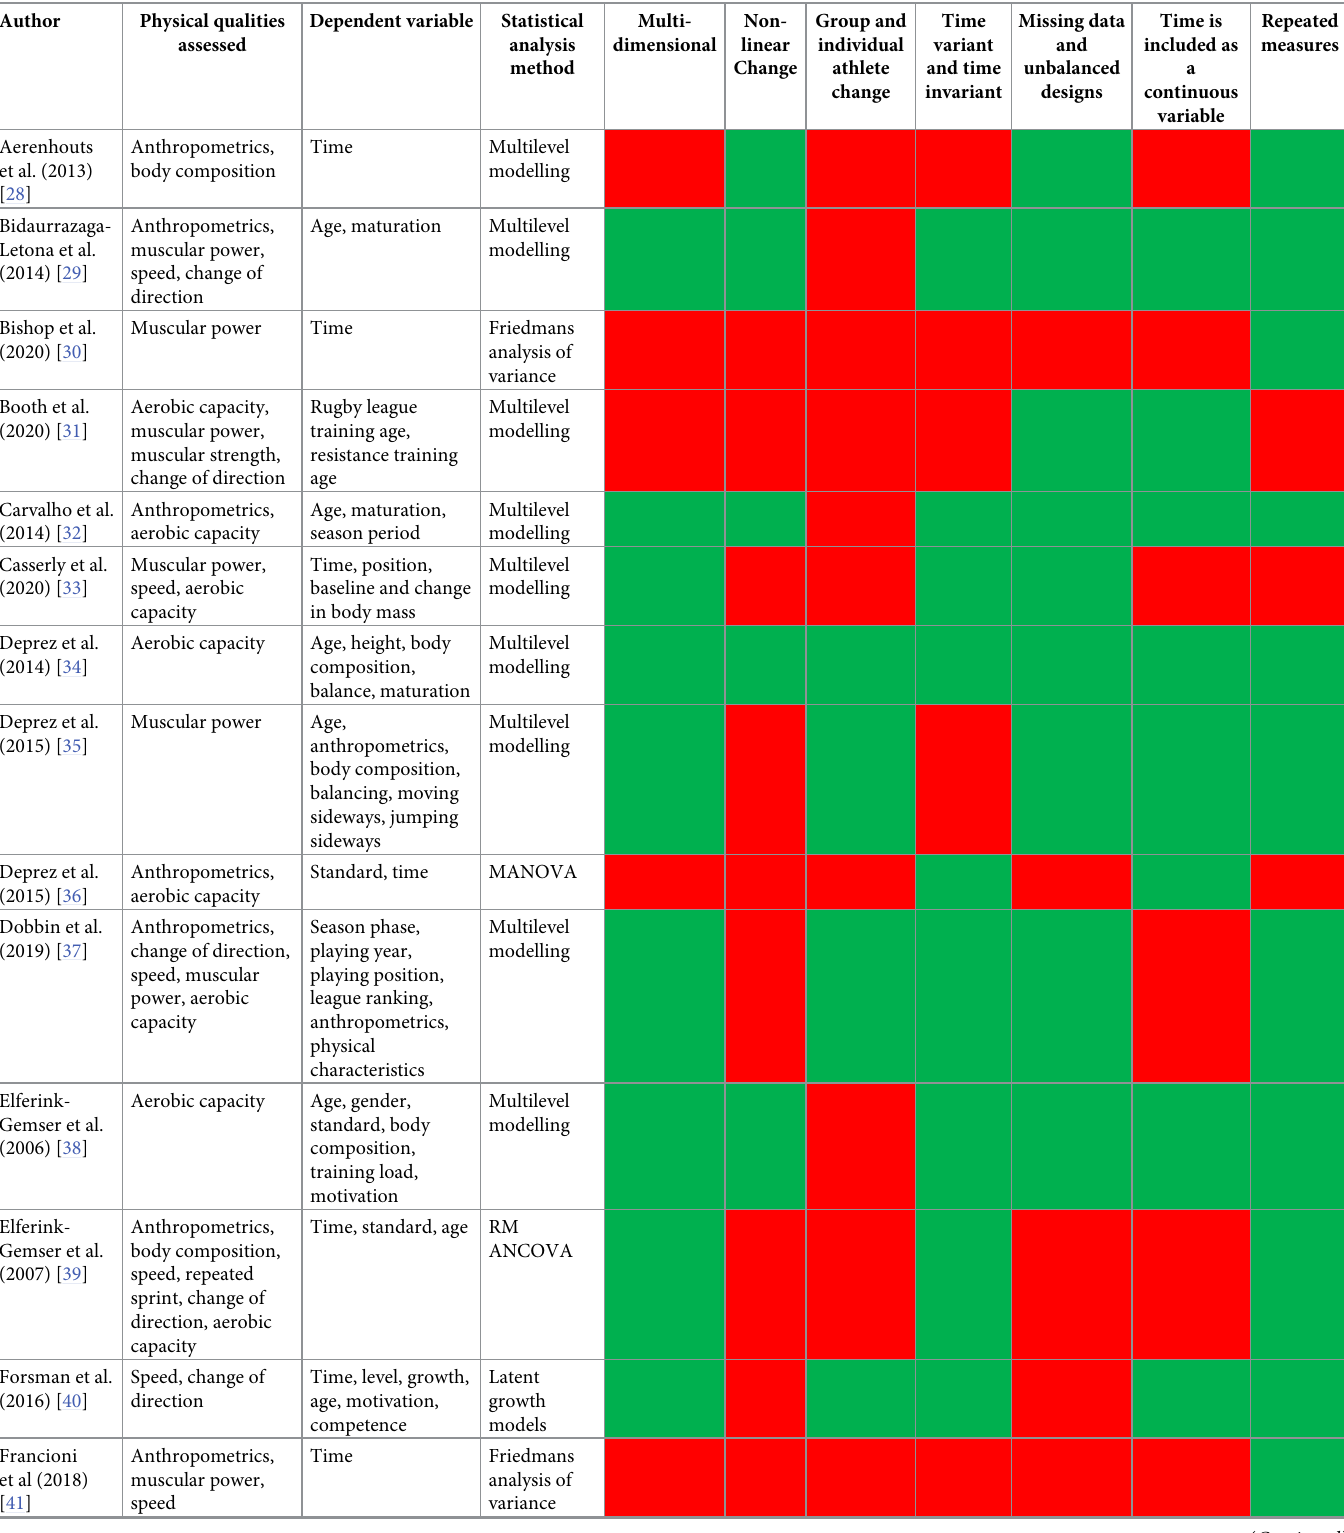
Table 7. Study information and individual qualitative